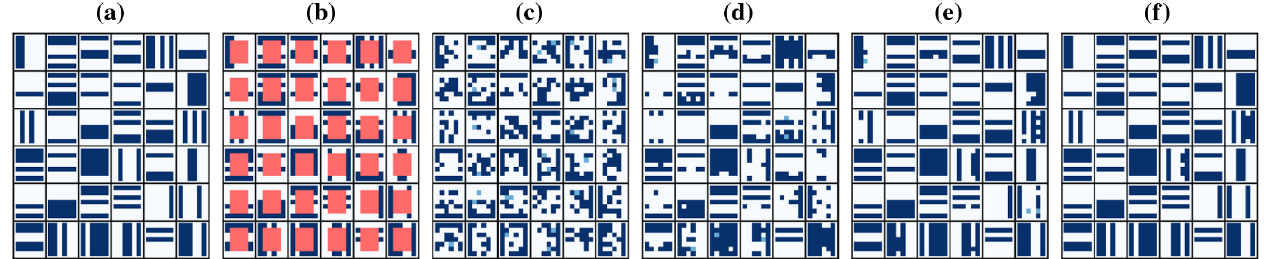
FIG. 5. BAS experiment. (a) We show 36 samples from the test set, with each pixel being either dark blue ( þ 1 ) or white ( − 1 ). (b) A 5 × 4 block of noise shown in red corrupts each picture. The model cannot use information from the red area, and yet the remaining pixels contain enough information to reconstruct the original picture. (c) – (f) Reconstructions obtained after 1, 10, 1000, and 3850 learning iterations. The average number of mistaken pixels is 50% in (c), 18.6% in (d), 2.95% in (e), and finally 0.65% in (f). This is an almost perfect reconstruction. The learning stops at iteration 3850 because further iterations would bring some parameters out of the dynamical range of the DW2X